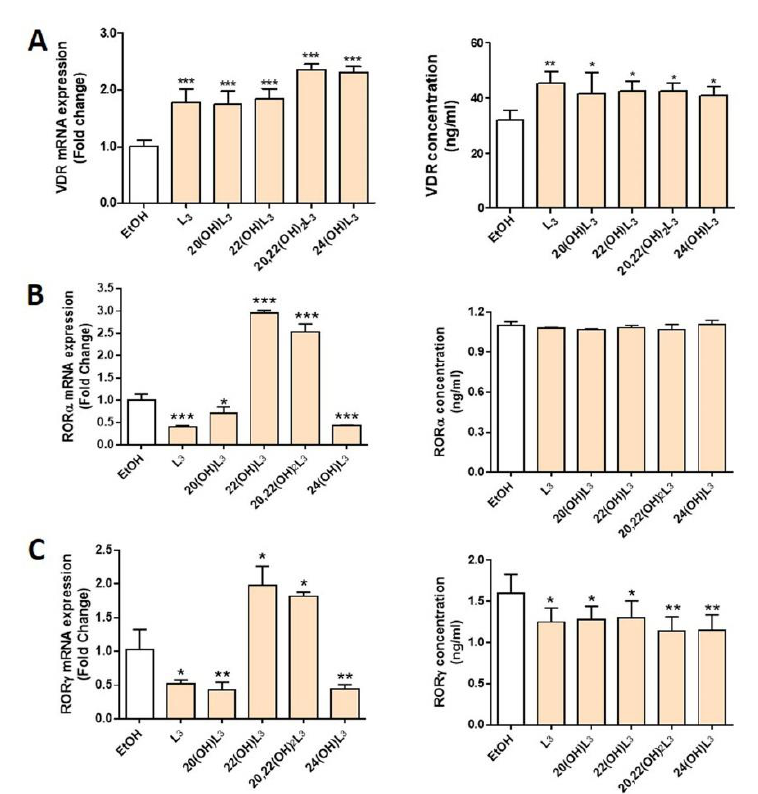
Figure 2. Modulation of the expression of mRNA for the vitamin D receptor (VDR) and retinoic acid-related orphan receptors α and γ (ROR α / γ ) in keratinocytes treated with L3 derivatives. Keratinocytes were treated with 100 nM lumisterols (shown as light orange bars) or ethanol (solvent control, shown as white bar) for 24 h. Real-time RT-PCR analysis and immunodetection were performed to measure ( A ) VDR, ( B ) ROR α , and ( C ) ROR γ mRNA and protein levels (ng / mL), respectively. The mRNA level of the targeted gene was normalized relative to the housekeeping genes, cyclopilin, and GAPDH mRNA levels. The concentrations of nuclear receptors (ng / mL) were measured by ELISA and were calculated from reading the absorbance at 450 nm from the appropriate standard curve. The statistical significance of di ff erences was evaluated by the one-way ANOVA, * p < 0.05, ** p < 0.01, *** p < 0.001, for all conditions relative to the untreated ethanol control, n = 3.